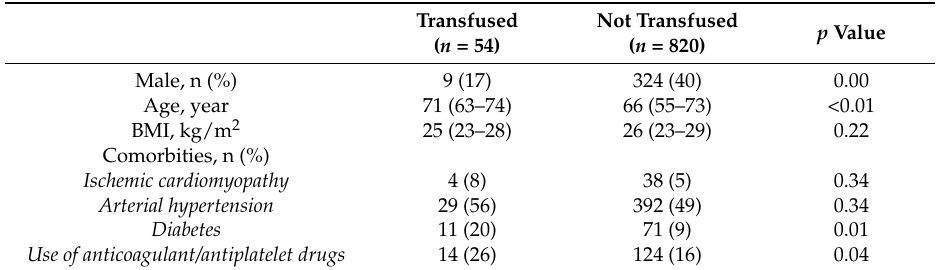
Table 2. Comparison between transfused and not transfused